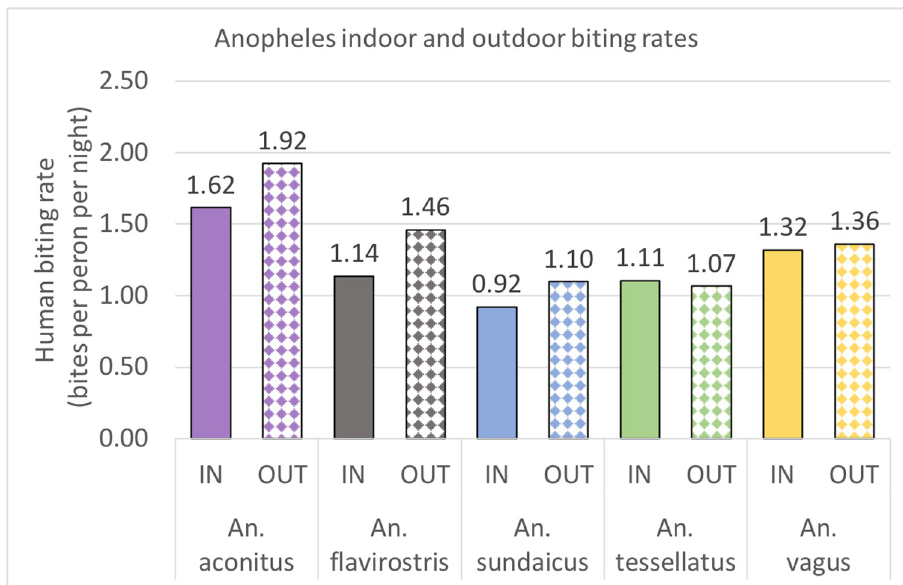
Fig 3. Indoor and outdoor biting rates of Anopheles